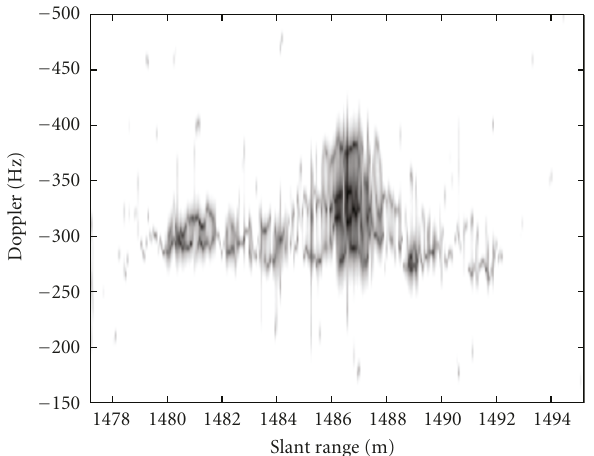
Figure 13: ISAR image obtained by applying MUSIC to the real data.